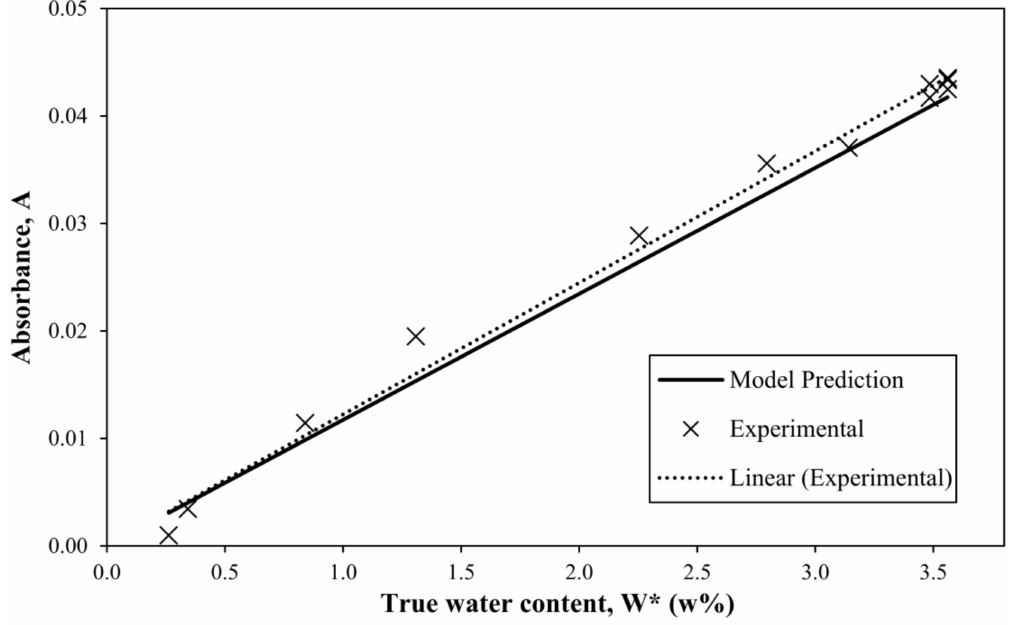
Figure 6. Validation of the water monitoring model extended to